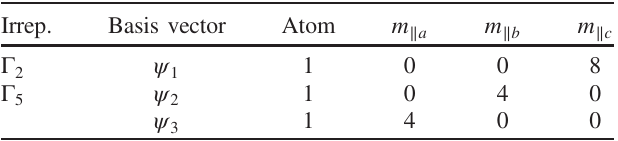
¯4 m 2 with TABLE XI. Unrenormalized exchange interactions used for model spin-wave calculations in FeSc 2 S 4 . Bonds are labeled according to Fig.